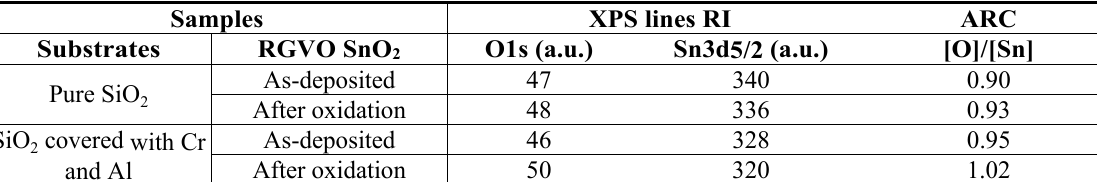
Figure 1. XPS survey spectra with the main core level lines of: ( a ) RGVO SnO 2 nanolayers deposited on SiO 2 substrate both as deposited and after additional oxidation, together with the corresponding O – Sn3d spectral window (in the inset); ( b ) RGVO SnO 2 nanolayers deposited on SiO 2 substrate modified with Cr and Al additives both as deposited and after additional oxidation, together with the corresponding O–Sn3d spectral window (in the inset). Table 1. The results of XPS investigation: relative intensity (RI) of XPS lines and the atomic relative concentrations (ARC) of the main components for RGVO SnO 2 nanolayers.